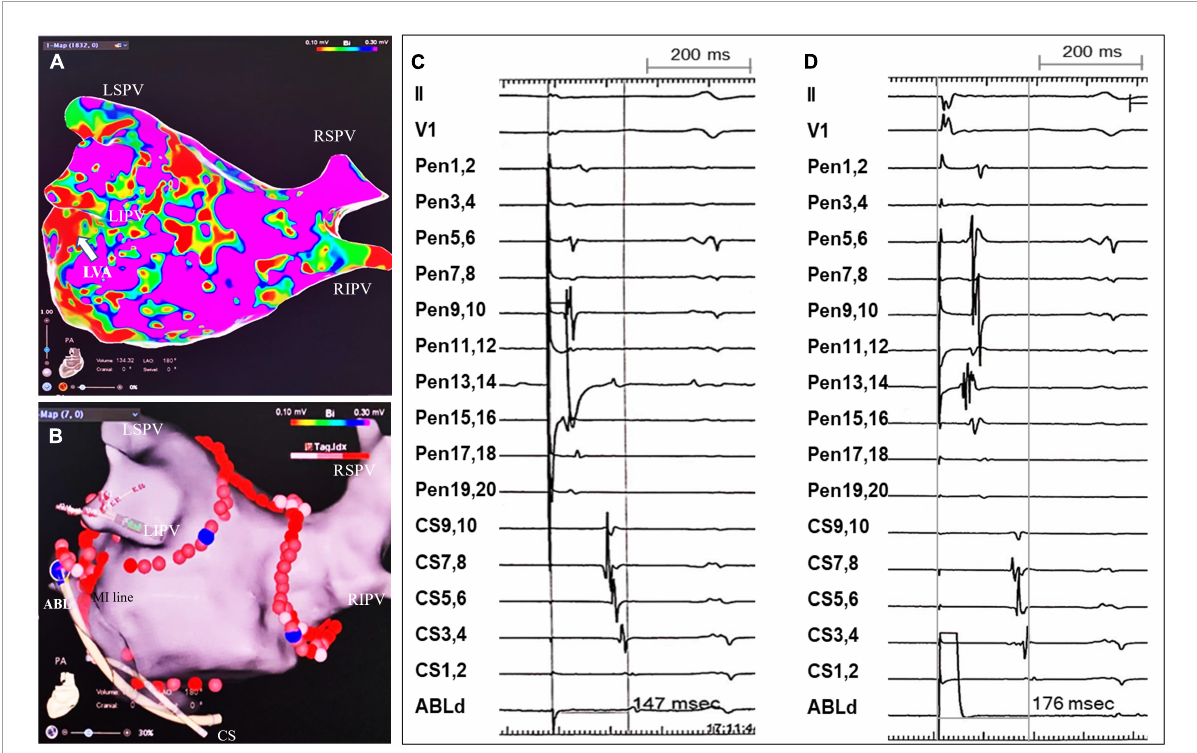
FIGURE2 An example of MIth linear ablation and validation of MIth block. (A) LA substrate mapping post-EIVOM displayed a patchy LVA (white arrow) in the MIth region. (B) An entire MIth lesion line was created connecting the MA and the inferior aspect of LIPV’s ostium, across the EIVOM-related LVA. Note epicardial CS ablation was applied after failure of MIth block by endocardial MIth ablation. (C,D) Tracings were surface ECG lead II, V 1 , PentaRay 1 , 2 -PenraRay 19 , 20 , CS 9 , 10 - CS 1 , 2 and ABL 1 , 2 . (C) Pacing from PentaRay 13 , 14 (positioned within LAA) displayed the proximal to distal CS activation sequence. The interval from LAA pacing to CS1,2 WAS 146 milliseconds (ms). (D) The ablation catheter tip (ABL) was positioned just lateral to the MIth line [shown in panel (B) ]. The interval from pacing from ABL 1 , 2 to CS 1 , 2 was 176 ms, which was longer than that from pacing from LAA to CS1,2 (146 ms), indicating the MIth line was blocked. LSPV, left superior pulmonary vein; RSPV, right superior pulmonary vein; LIPV, left inferior pulmonary vein; RIPV, right inferior pulmonary vein; LVA, low voltage area; MIth, mitral isthmus; CS, coronary